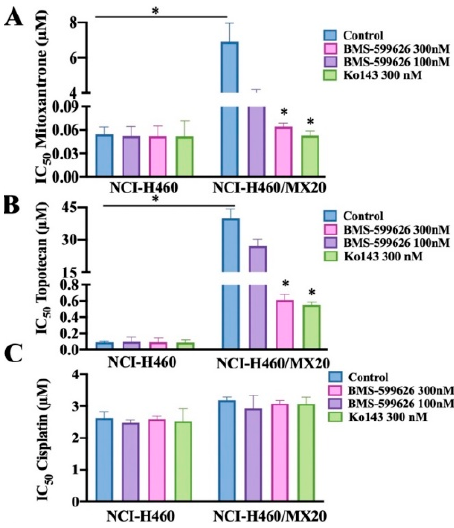
Figure 2. Effect of BMS-599626 on multidrug resistance (MDR) in parental and ABCG2- Figure 2. E ff ect of BMS-599626 on multidrug resistance (MDR) in parental and ABCG2-overexpressing overexpressing cells. ( A ) The IC 50 of mitoxantrone in NCI-H460 and NCI-H460/MX20 cells with or cells. ( A ) The IC 50 of mitoxantrone in NCI-H460 and NCI-H460 / MX20 cells with or without BMS-599626 andKo143, ( B )theIC 50 oftopotecaninNCI-H460andNCI-H460 / MX20cellswithorwithoutBMS-599626 and Ko143, ( C ) the IC 50 of cisplatin in NCI-H460 and NCI-H460 / MX20 cells with or without BMS-599626 and Ko143. Mean values from three independent experiments are given and error bars indicate SD. (*) indicates p < 0.05 compared to control group.